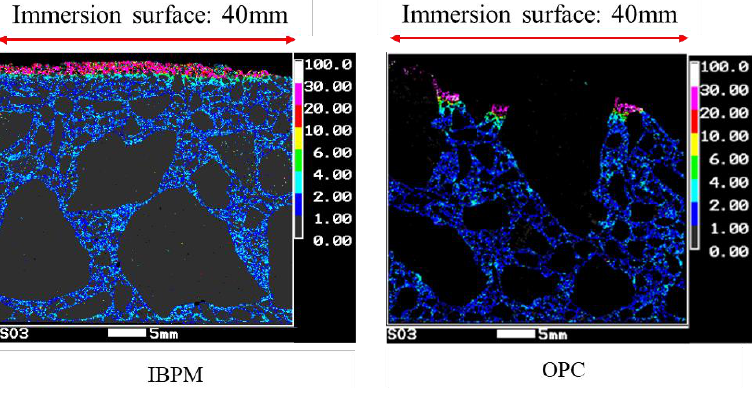
Figure 11. EPMA image of the test pieces near the exposed surface. Table 7. Sulfuric acid resistance of the internal portion of centrifugally molded specimens. Binder